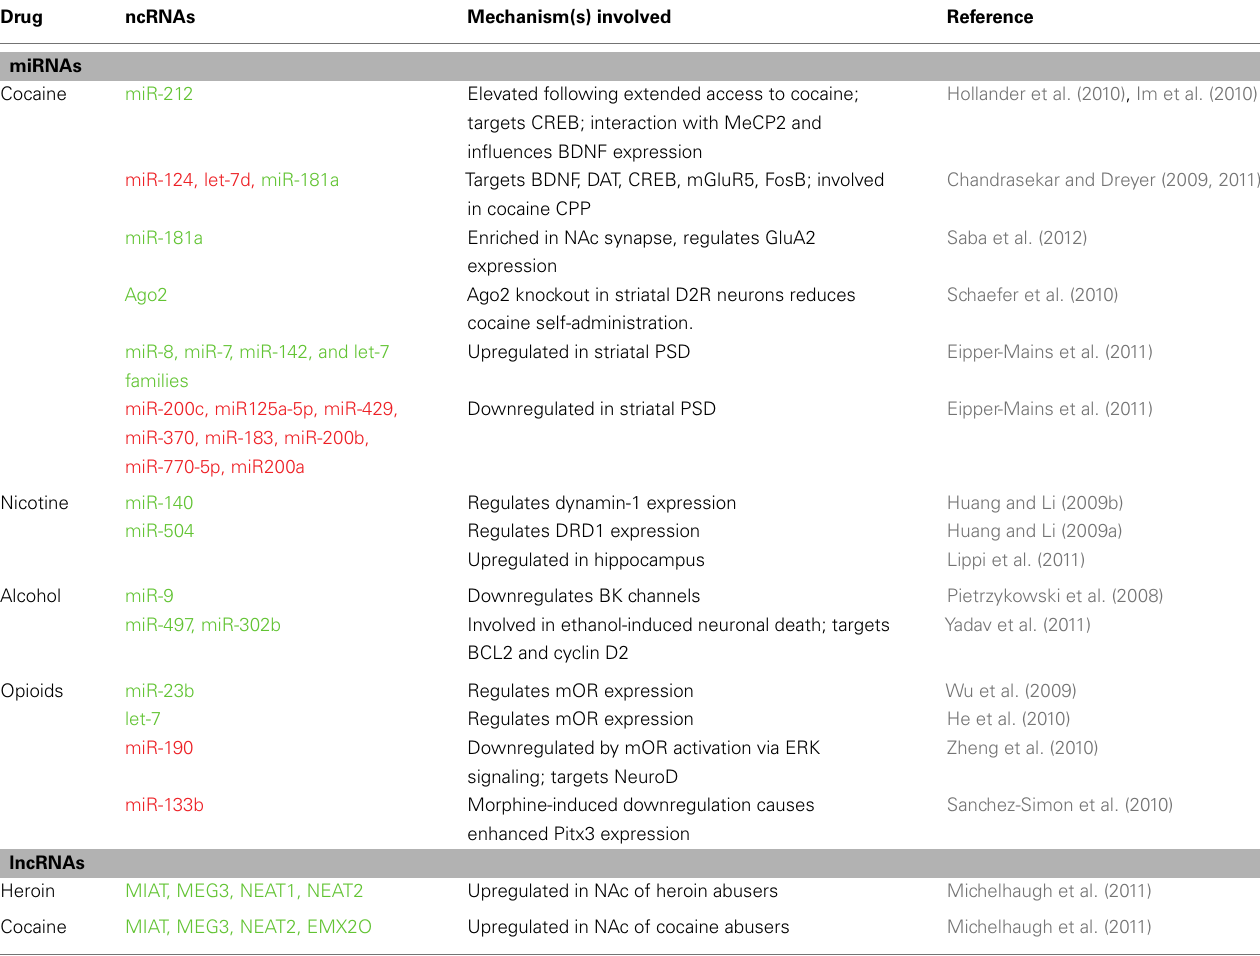
Table 1 | ncRNAs regulated by drugs of abuse (green = upregulation, red = downregulation).